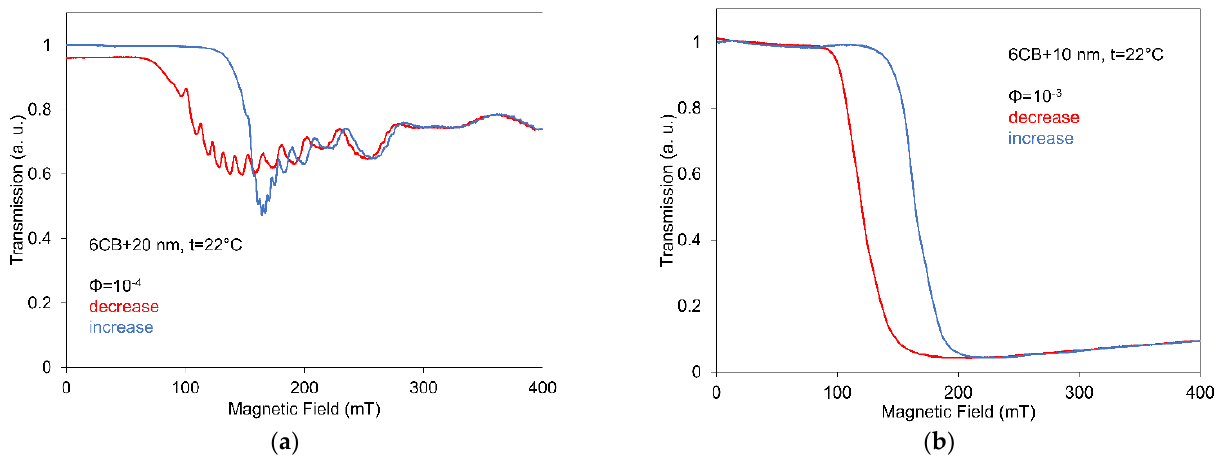
Figure 5. Magneto-optical characteristics of 6CB liquid crystal doped with spherical magnetic nanoparticles with volume concentrations 10 − 4 ( a ) and 10 − 3 ( b ) measured for increasing and decreasing magnetic field.